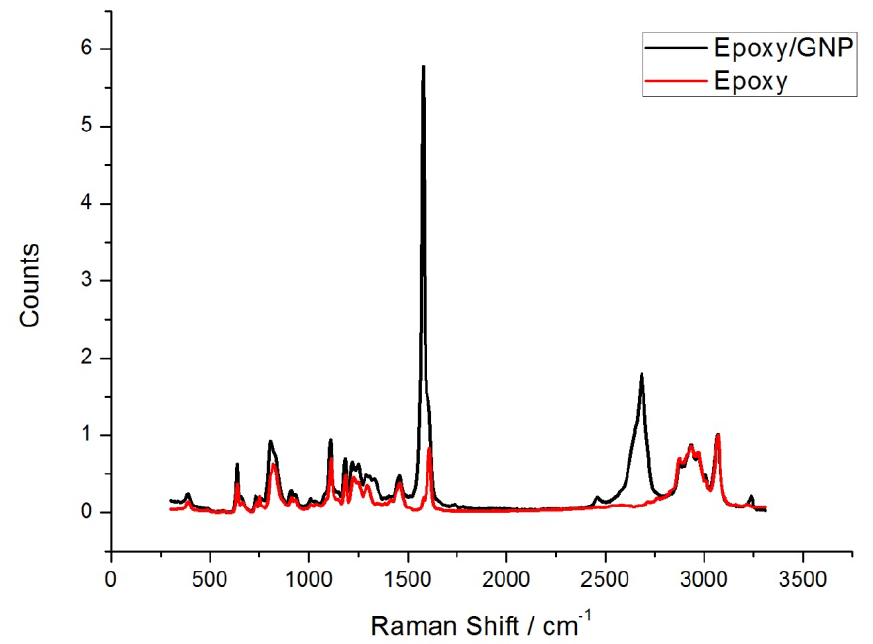
Figure 4. Raman spectrum of epoxy resin(red) and an Epoxy/GNP composite(black).